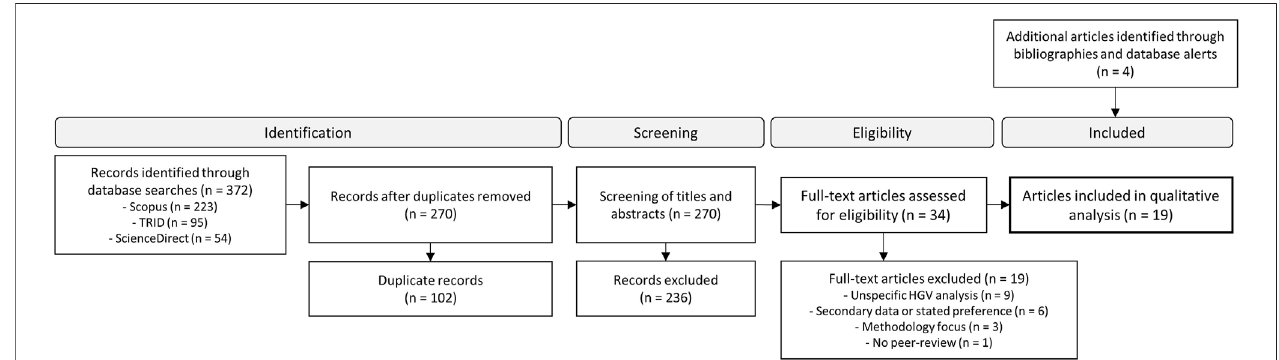
FIGURE 2 | Search and selection fl ow